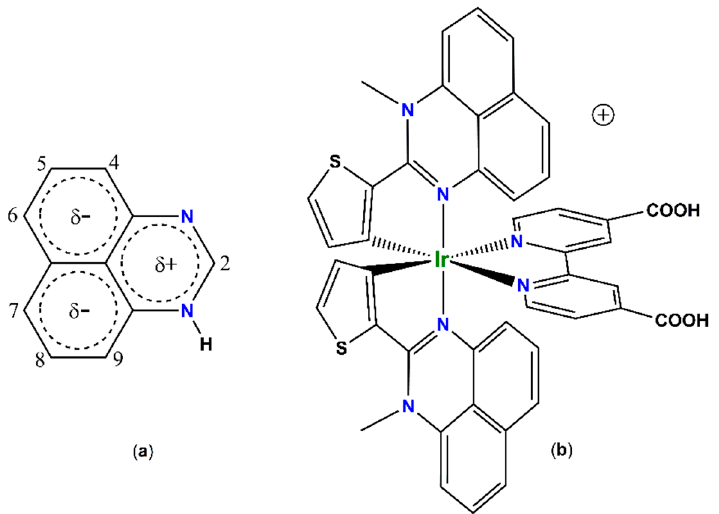
Figure 1. ( a ) Carbon atom numbering and distribution of the electron density in 1-H-perimidine. ( b ) Targeted structure of a cationic cyclometalated iridium(III) complex containing two electron-donor 2-arylperimidine ligands and electron-withdrawing 4,4 ′ -dicarboxy-2,2 ′ -bipyridine.